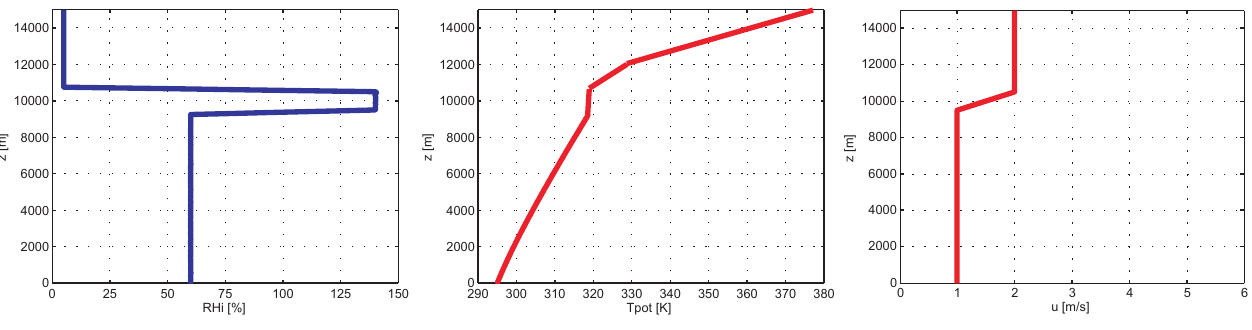
Fig. 2. Vertical profiles used for the reference simulation. Left: RHi profile; middle: potential temperature profile; right: horizontal velocity